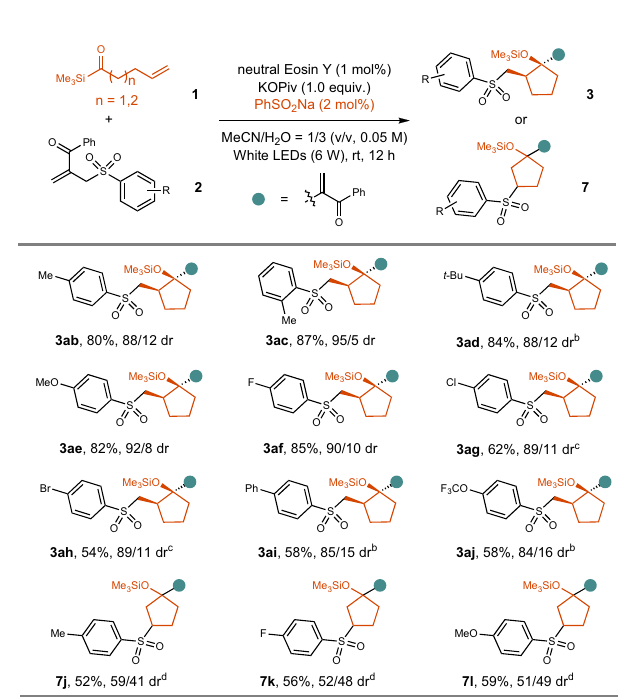
Fig. 5 | Scope for the synthesis of different sulfonyl group-substituted cyclopentanol derivatives. a Total yield of the isolated two diastereoisomers is reported. b ArSO 2 Na (20mol%) was used. c PhSO 2 Na (5mol%) was used. d ArSO 2 Na (2 equiv.) was used, MeOH/H 2 O=1/2